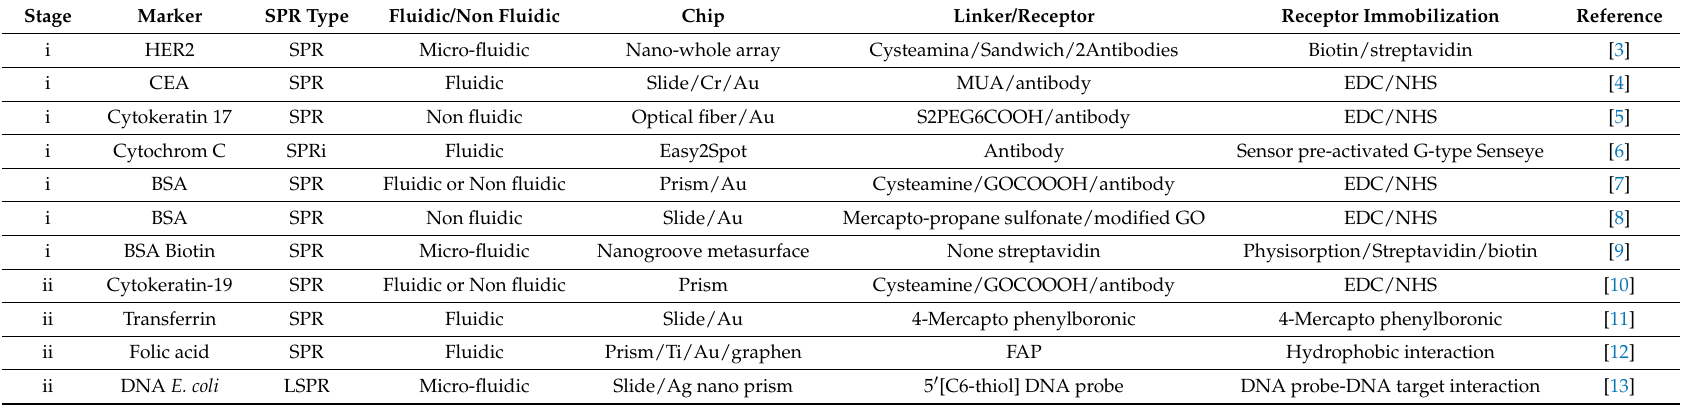
Table 1. Technical solutions for biosensors in the initial stages of